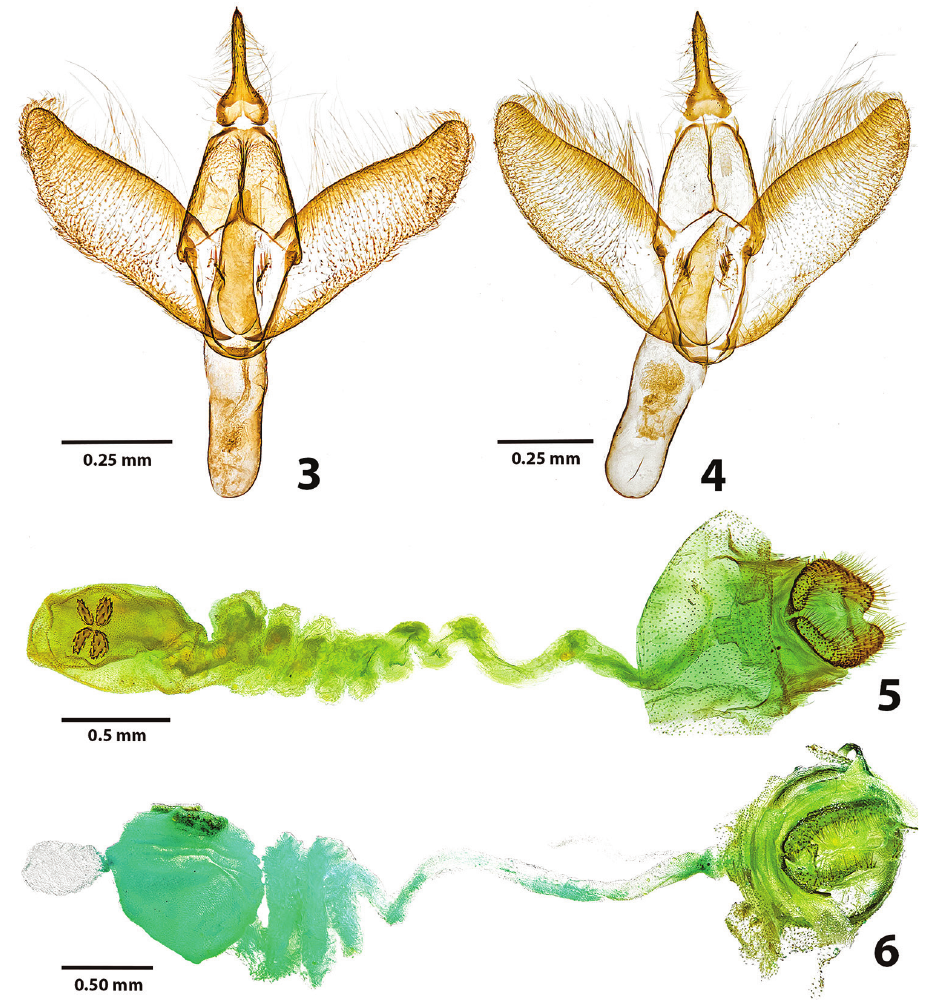
Figures 3–6. Lactura genitalia. 3 HOLOTYPE male Lactura rubritegula TX: Kendall Co., Boerne, D. Cain Home (29°52'51N, 98°36'51"W), 27 April 2015, David Wagner & Delmar Cain colls., CO1 Barcode DLW-000816 Genitalia slide # TAM-2017-002 4 Male Lactura basistriga TX: Hidalgo Co., Bentsen St. Pk., Lactura rubritegula . TX: Kendall Co., Boerne, D. Cain Home (29°52'51N, 98°36'50"W), 27 April 2015, David Wagner & Delmar Cain colls., Genitalia slide # TAM-2017-001 6 Female Lactura basistriga . TX: emerged 21 May 2015, Berry Nall coll., Host: Sideroxylon celastrinum , Genitalia slide # TAM-2017-005.